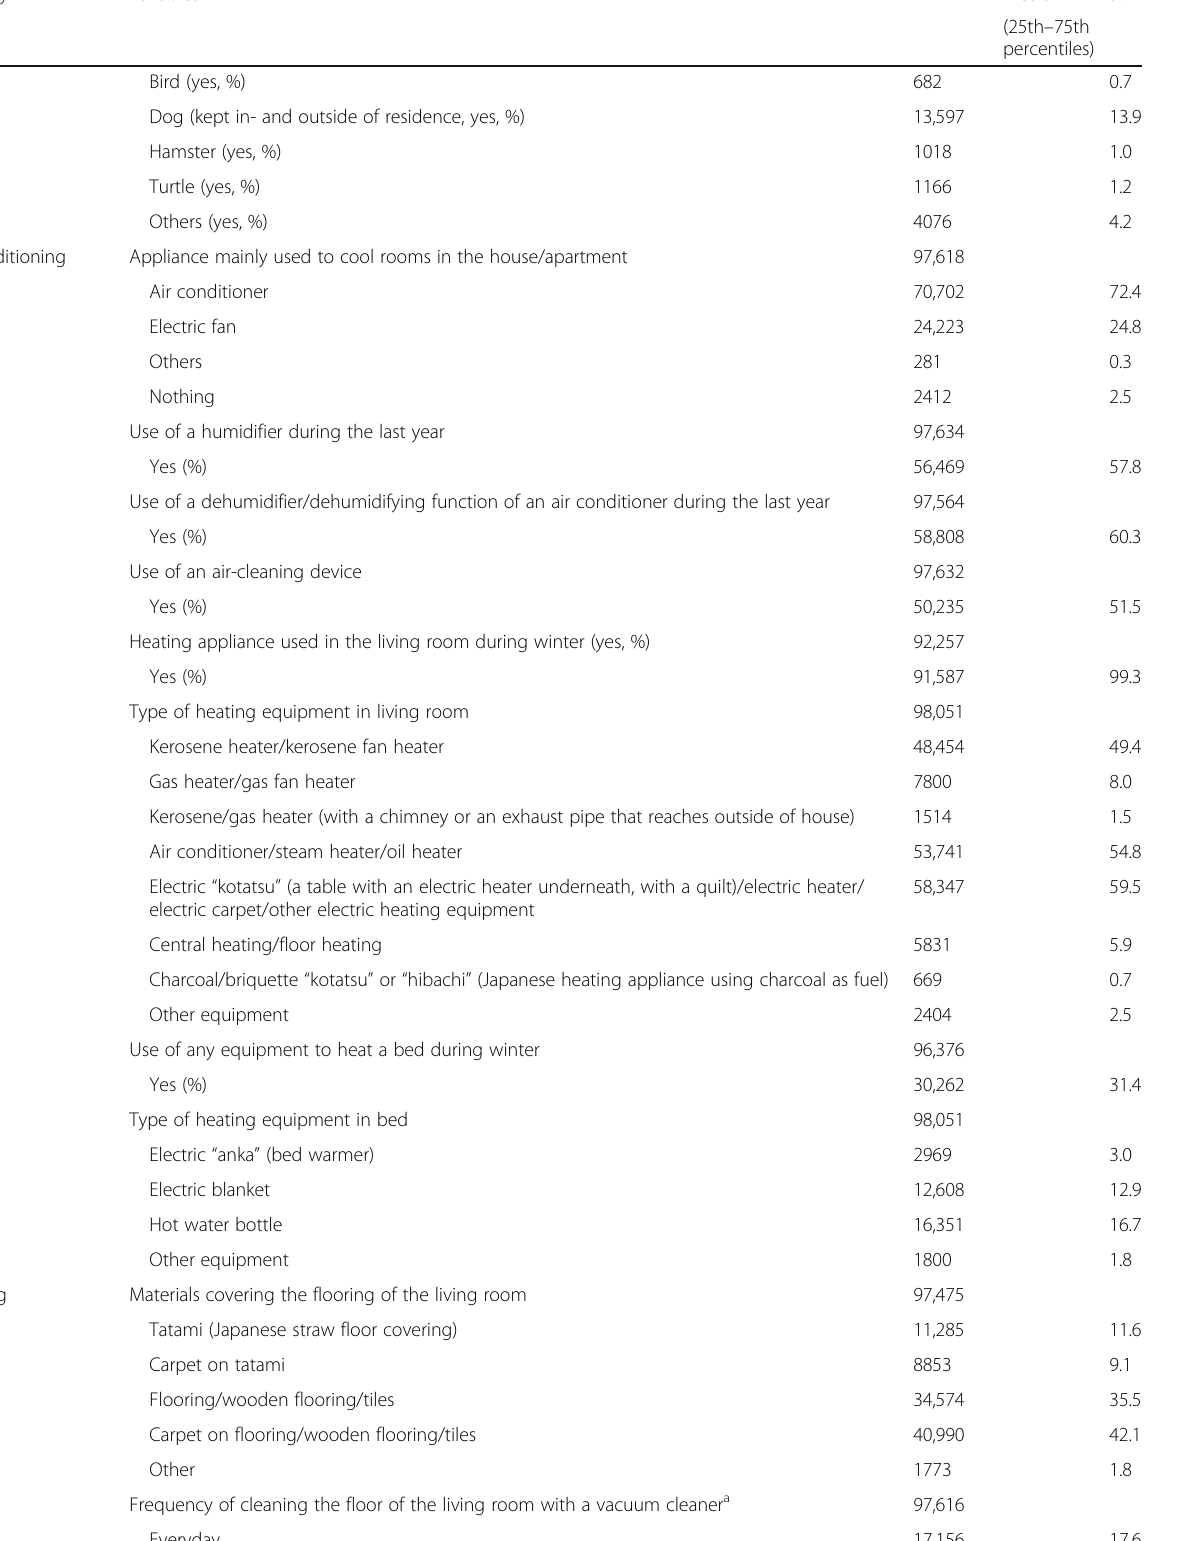
Table 5 Household environment characteristics during pregnancy (MT2) (Continued)